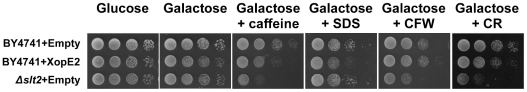
XopE2 causes sensitivity to cell wall stressing agents.The indicated yeast strains containing pGML10, either empty or encoding XopE2, were normalized to OD600 = 1.0 and spotted in 10-fold serial dilutions on repressing (2% glucose) and inducing (2% galactose and 1% raffinose) plates with the indicated cell wall stressing agents: caffeine 7 mM; SDS 0.003% (w/v); Congo red (CR) 100 µg ml−1; calcofluor white (CFW) 100 µg ml−1.